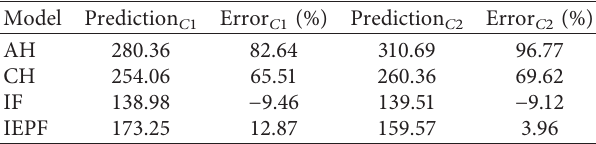
Table 15: Ultimate bearing capacity prediction for example 3.